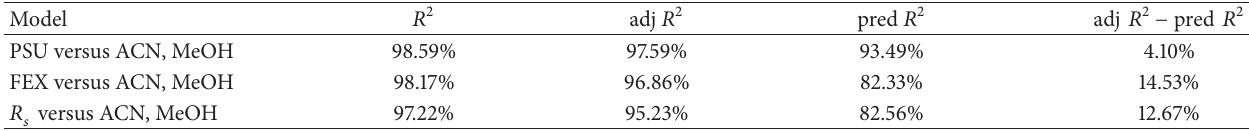
Table 5: Model summary for transformed